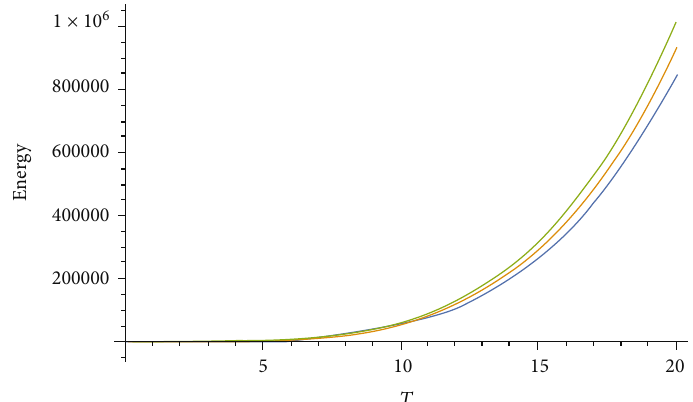
Figure 1: The Stefan-Boltzmann law with corrections due to the aether term. The blue curve presents the standard result, that is, the Lorentz invariant Stefan-Boltzmann law, while the yellow and green curves show the Stefan-Boltzmann law with corrections due to the Lorentz violation for λ = 0 : 1 and λ = 0 : 2 ,